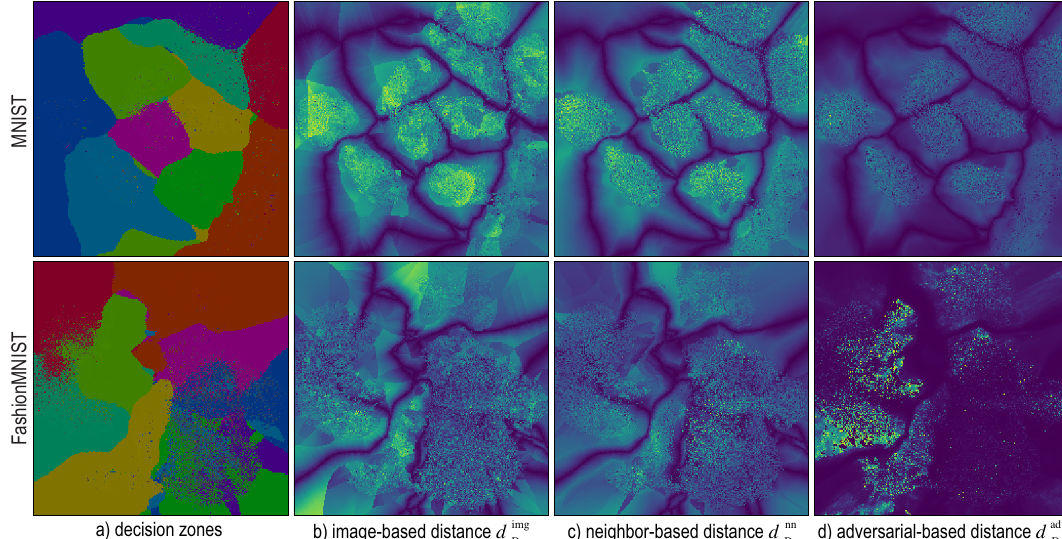
Figure 10. Dense map and distance maps for MNIST (top row) and FashionMNIST dataset (bottom row), with projection P set to UMAP and P − 1 to NNInv